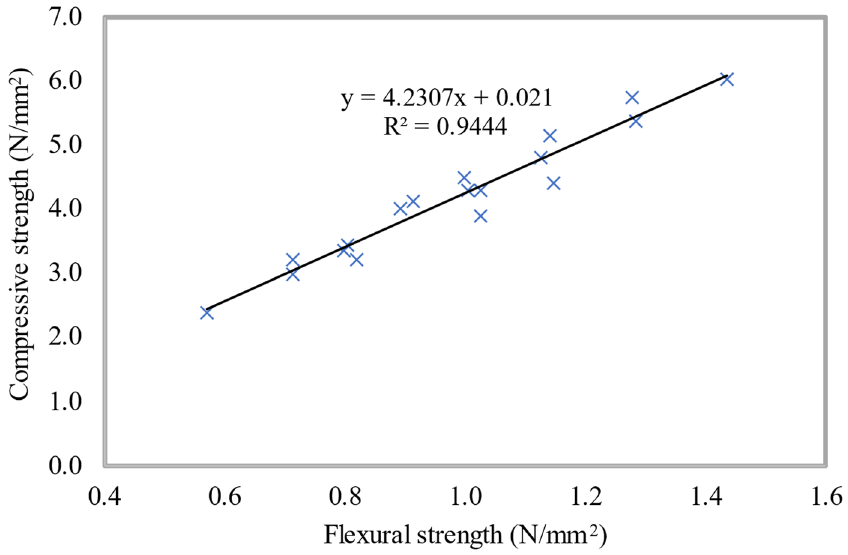
Figure 24. Relationship between the flexural and compressive strengths for 900 kg/m 3 density.